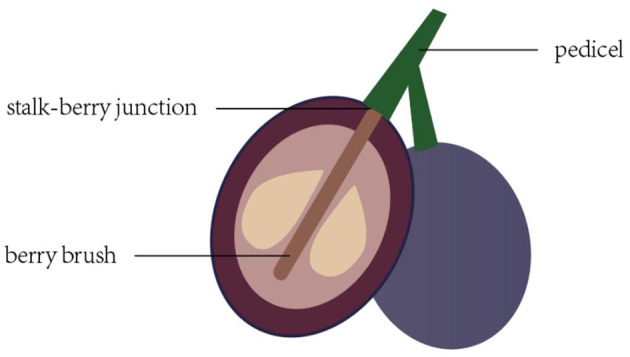
Stalk–berry junction, berry brush, and pedicel of the grape berry and sampling site used for cell structure determination.